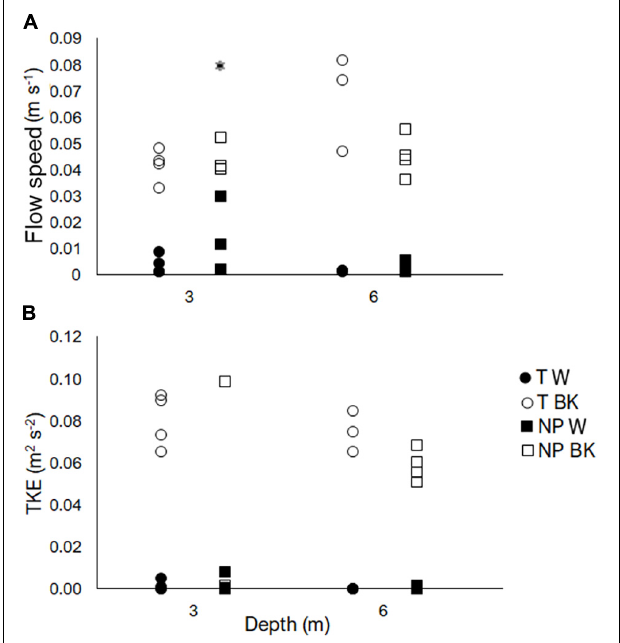
FIGURE 2 | Flow speed (A) and turbulent kinetic energy (TKE) (B) measured within the canopy (W) and background (BK) at Ninepin Point (NP) and Tinderbox (T) and at two depths, 3 and 6 m. Circles refer to individual measurements at Tinderbox and squares refer to individual measurements at Ninepin Point. Filled points are measurements within the canopy and open points refer to the background. N = 3–4 for each site and canopy or background combination. Measurements were carried out during the period March 2nd – 9th, 2017. Asterisk denotes significant difference of within canopy measurements only between site and depth (LSD), P <